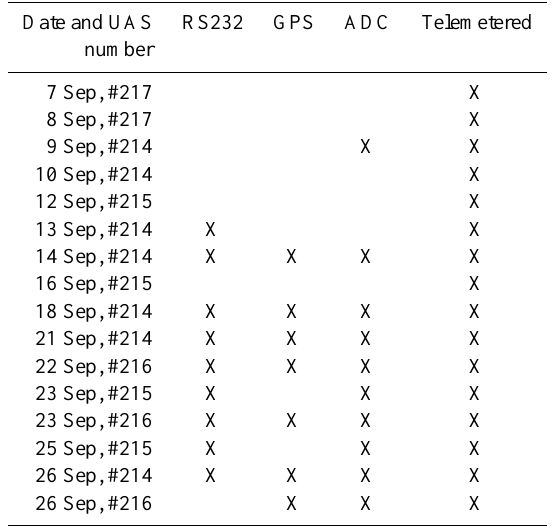
Table 4. Data available in the four logger and one telemetered data streams. Sampling rates are also given.